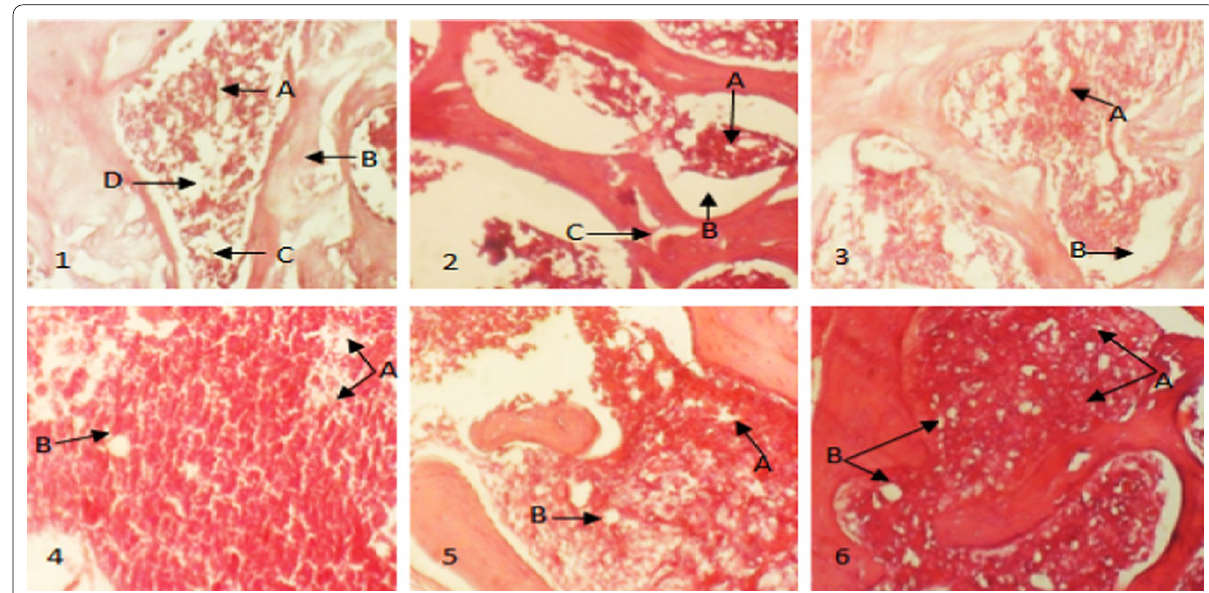
Fig. 9 Effect of n-hexane leaf extract of Ipomoea batatas L . on myeloid–erythroid cells in albino rats. (1) showed the control rat bone marrow composed of A—megakaryocyte, B—bone, C—myelo-erythroid cells, and D—fat vacuoles, ( 2 ) phenylhydrazine alone showed moderately decreased A—marrow, B—fat ratio and C—bone trabecula, ( 3 ) at 5 mg/kg of ferrous (iii) hydroxide, the results showed normal A—marrow, B—fat ratio, ( 4 ) at 125 mg/kg n-hexane leaf extract, our results showed moderately increased A—marrow, and B—fat ratio ( 5 ) at 250 mg/kg n-hexane leaf extract, the result found a moderately increased A—marrow and B—fat ratio ( 6 ) at 500 mg/kg n-hexane leaf extract, the result observed a moderately increased A—marrow and B—fat ratio, using haematoxylin–eosin dye with X 40 magnification